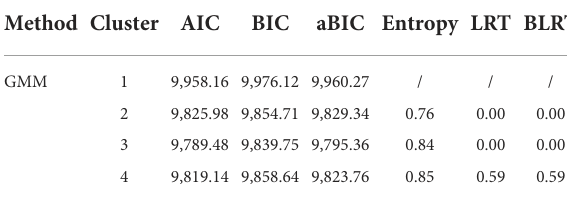
TABLE 1 Fit indices for growth mixture modeling analysis.